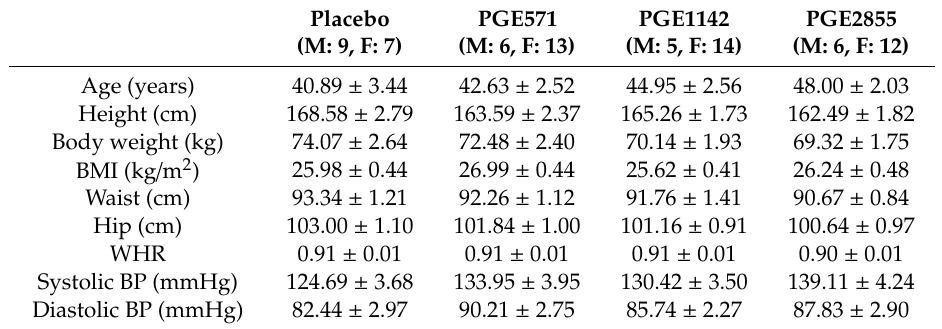
Table 2. Baseline characteristics of 4 groups with overweight or obesity subjects who participated